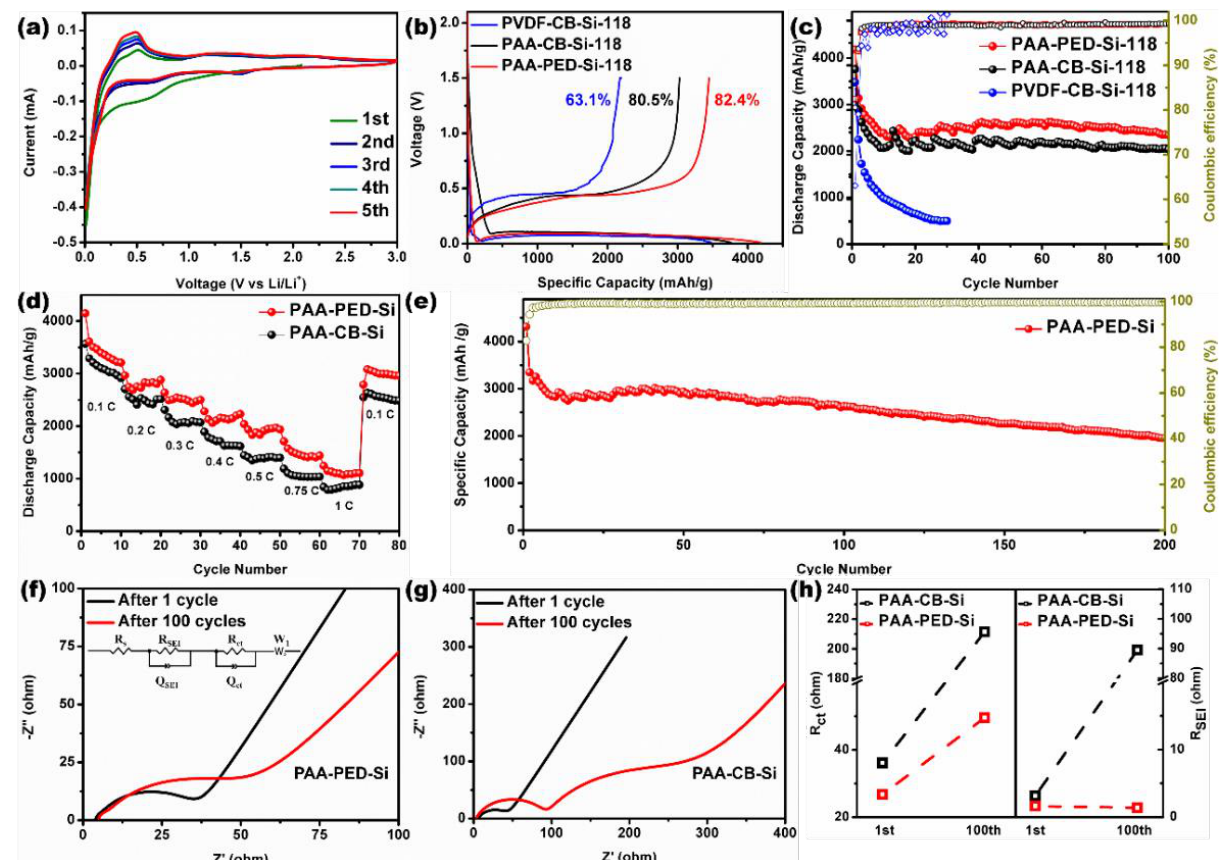
Figure 3. Electrochemical performances of Si−based electrodes. ( a ) The CV curves of the PAA−PED−Si electrode at a scanning rate of 0.2 mV s − 1 ; ( b ) typical charging and discharging voltage profiles of the PAA−PED−Si, PAA−CB−Si, and PVDF−CB−Si electrodes at 420 mA g − 1 ; ( c ) cycling performances of PAA−PED−Si , PAA−CB−Si, and PVDF−CB−Si electrodes in a voltage range from 0.01 to 1.5 V for 100 cycles at 1260 mA g −1 ; ( d ) rate performance of PAA−PED−Si electrode in the range of 0.1 C~1 C; ( e ) cycling performance of PAA−PED−Si electrode in a voltage range from 0.01 to 1.5 V over 200 cycles at 840 mA g −1 ; ( f ) EIS spectra of PAA−PED−Si electrode after 1st and 100th cycles; ( g ) EIS spectra of PAA−CB−Si electrode after 1st and 100th cycles; ( h ) impedance value of PAA−PED−Si and PAA−CB−Si electrode after 1st and 100th cycles.